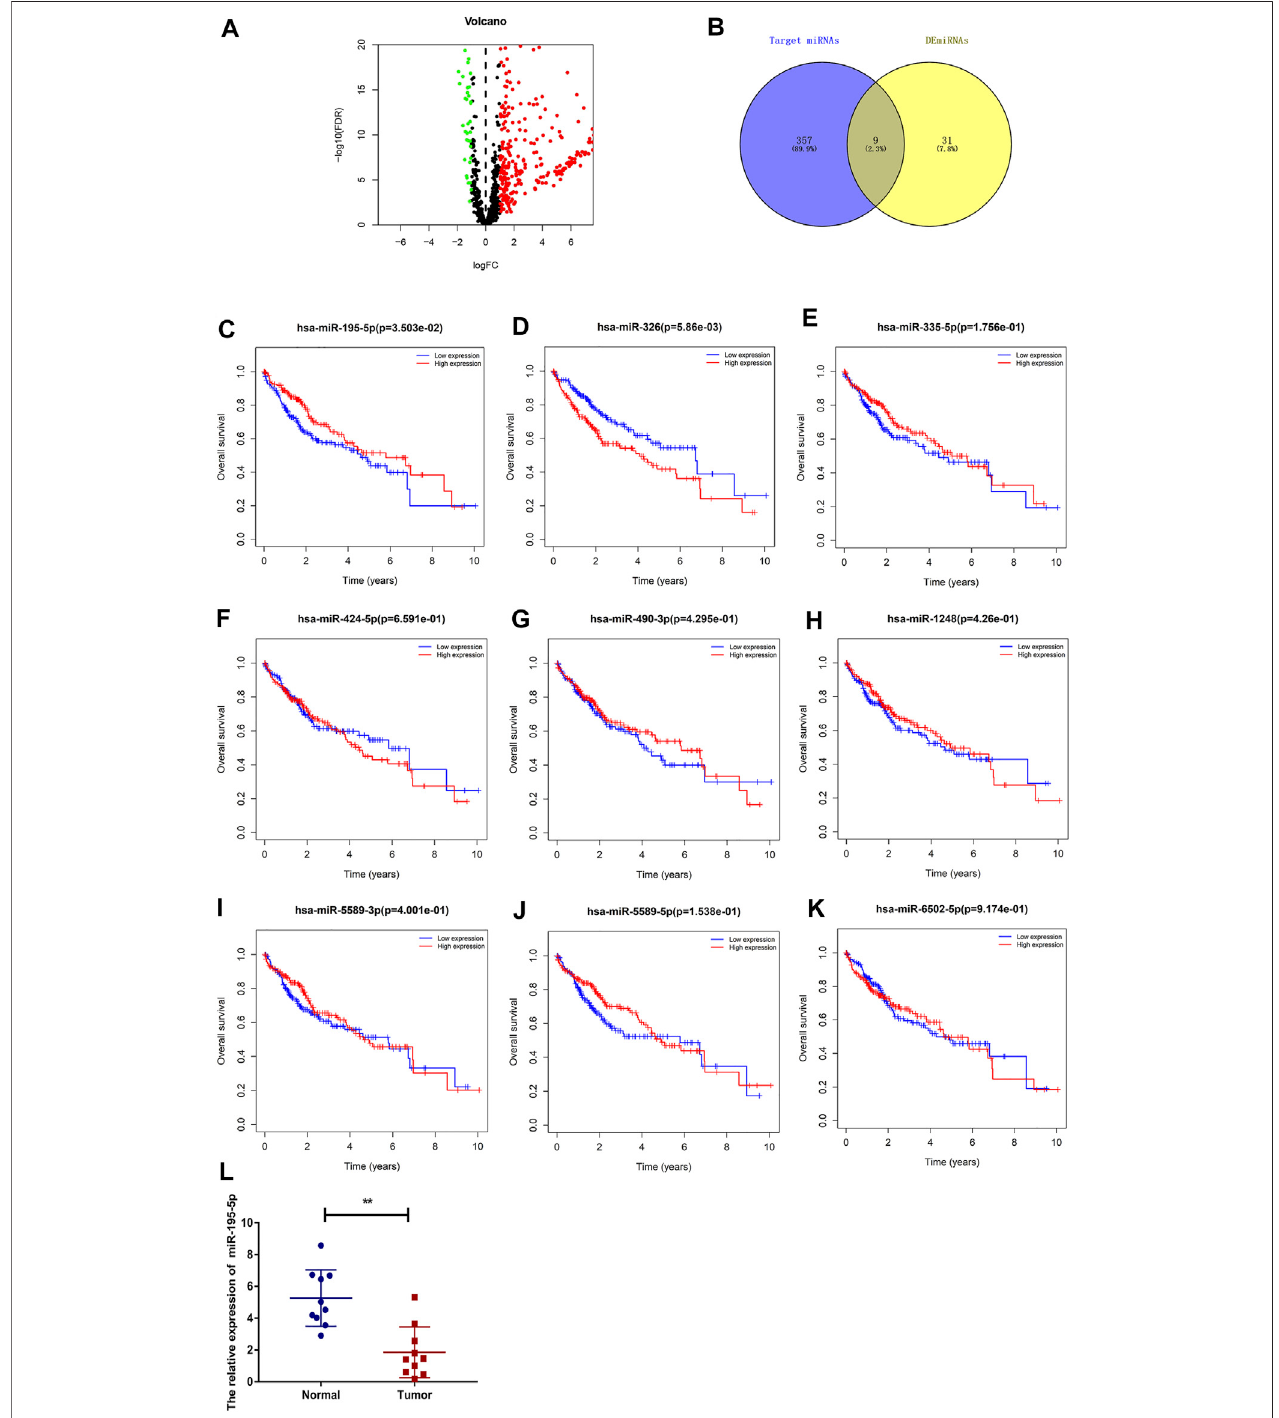
FIGURE5| Predictionand analysisofthebindingmiRNAs ofcircRNAs inLIHC. (A) ThevolcanoplotofDEmiRNAs inLIHCfromtheTCGA (adjusted p < 0.05and | logFoldChange| > 1). (B) Venn diagram analysis oftargetmiRNAs ofthe seven circRNAs and downregulated DEmiRNAs. (C – K) The prognostic value ofnine miRNAs in LIHC. (L) The expression of hsa-miR-195 – 5p in LIHC tissues and adjacent normal tissues ( n = 10).